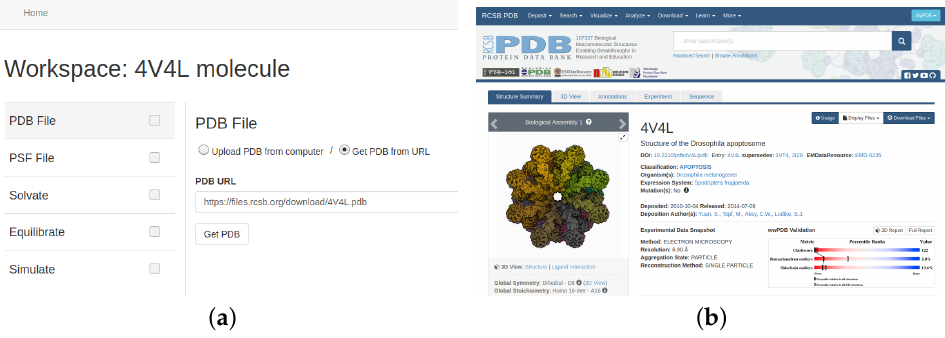
Figure 8. Molecular system loading process: ( a ) shows how a link is provided from the PDB; ( b ) shows the PDB’s 4V4L molecular